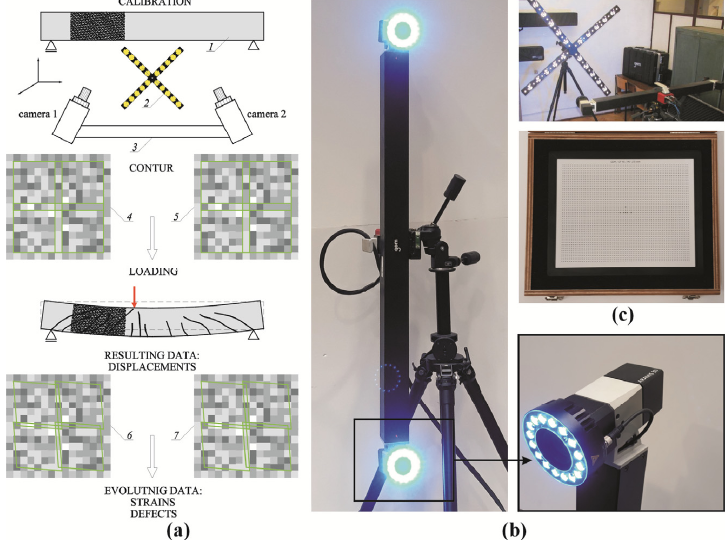
Figure 3. ARAMIS 6M system and its main components: ( a ) process diagram [5], ( b ) main measuring module—two cameras and light source, ( c ) calibration cross and plate1—test element, 2—calibration cross, 3—set of two cameras; 4, 5—left and right camera image prior to loading, divided into pixels and facets, 6,7—deformed facets recorded by left and right camera after loading.